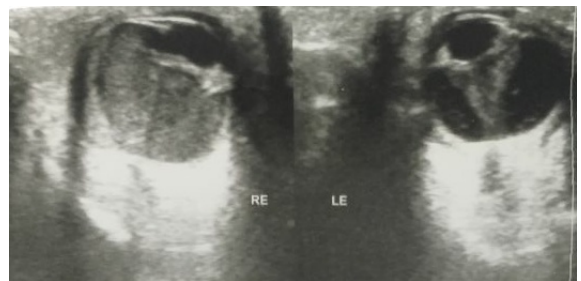
Figure 4: Ultrasound B-scan of the right eye (RE) and the left eye